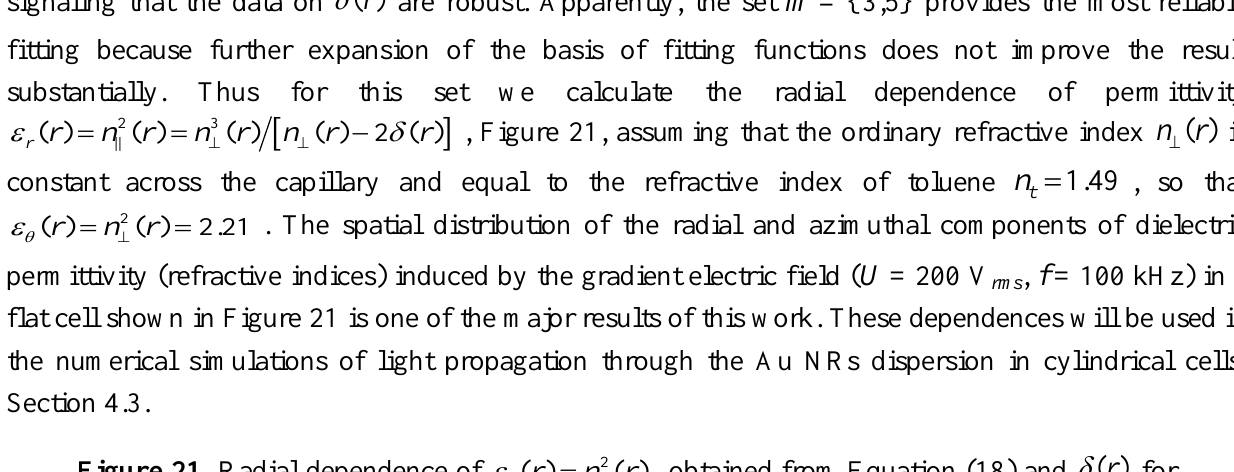
, obtained from Equation (18) and ( ) r  for 